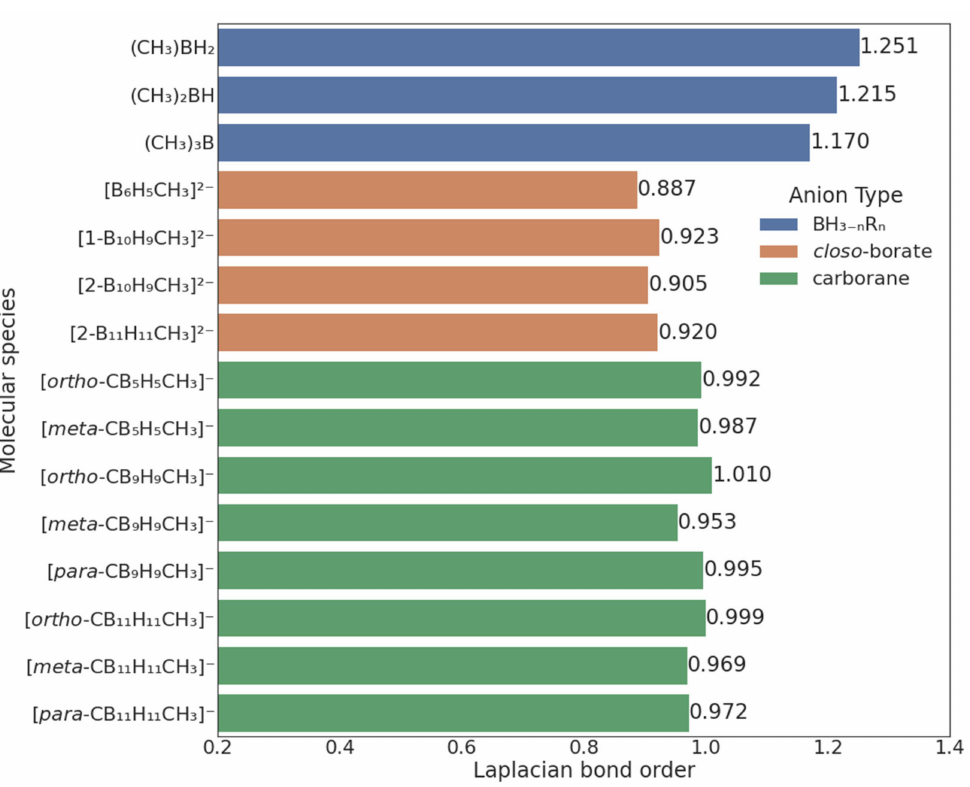
Figure 4. Values of B–C Laplacian bond orders in closo-borate anions of the general form [B n H n − 1 CH 3 ] 2 − (n = 6, 10, 12), monocarboranes [CB n H n CH 3 ] − (n = 5, 9, 11) and BH 3 − n (CH 3 )